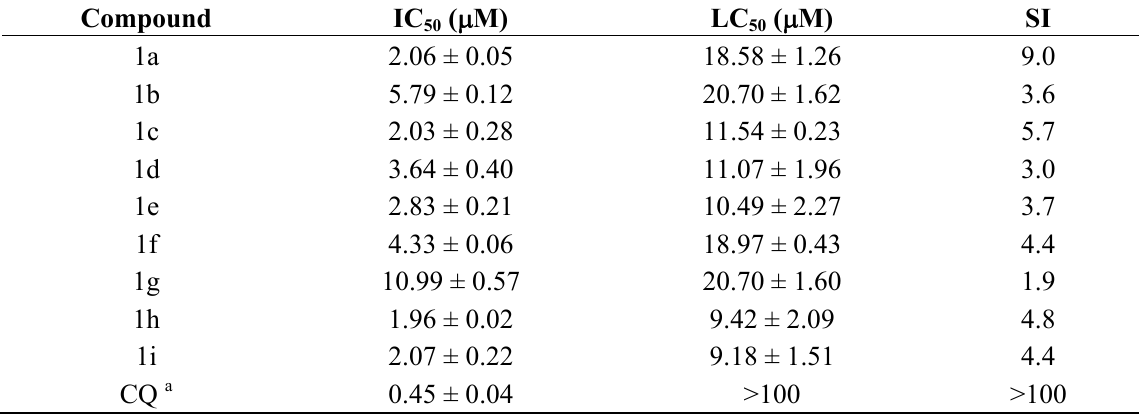
Table 1. In vitro antiplasmodial activity (IC (SI) of the 4-methoxychalconederivatives 1a – i